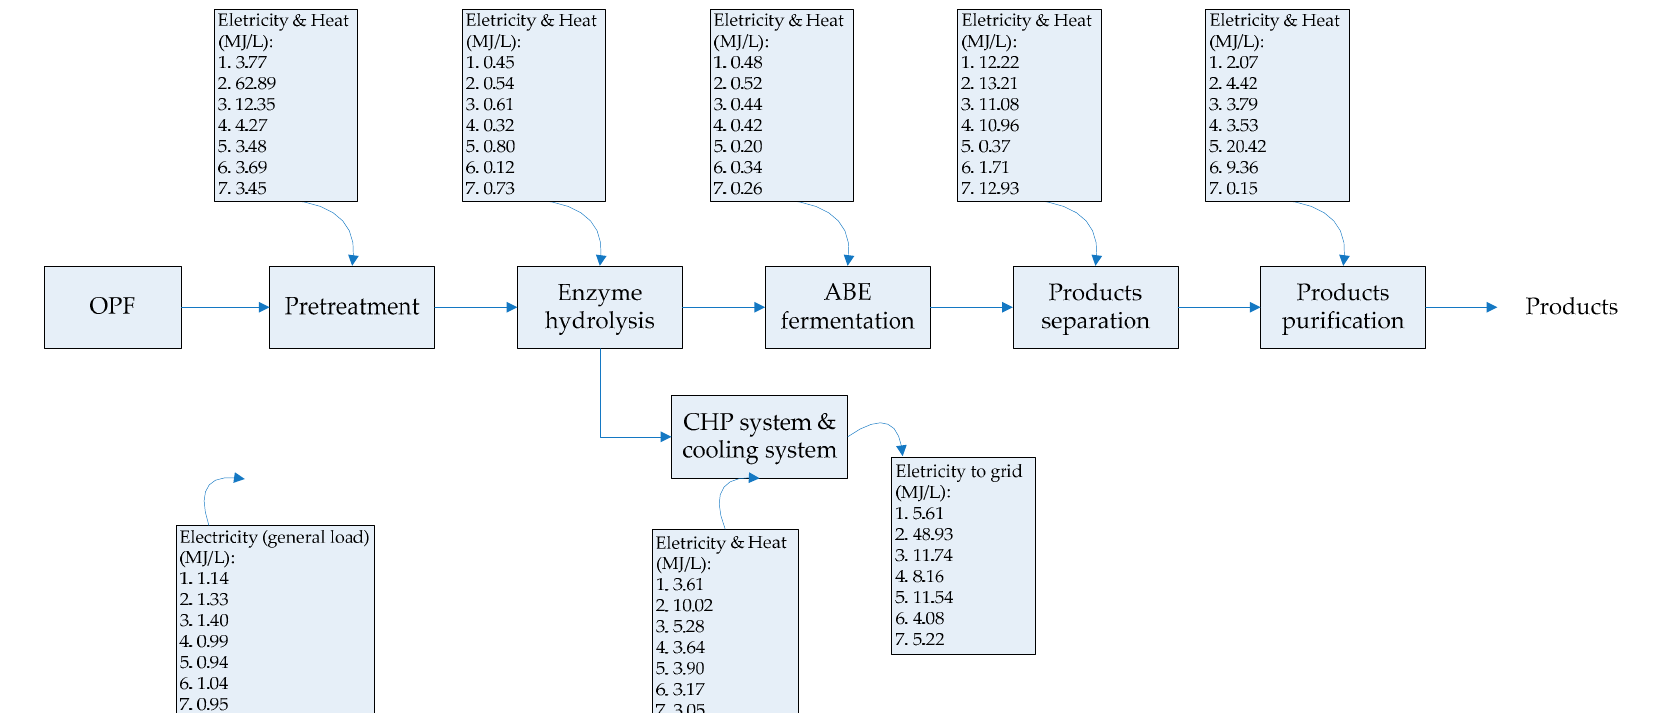
Figure 3. Energy required in each processing stage for butanol production. Numbering in boxes indicates various pretreatment or product separation steps. 1. low moisture anhydrous ammonia (LMAA) pretreatment / in-situ stripping; 2. autohydrolysis pretreatment; 3. soaking in aqueous ammonia (SAA) pretreatment; 4. NaOH pretreatment; 5. adsorption; 6. pervaporation; 7. dual extraction. The energy requirement / generated were assessed based on 1 L butanol. Products produced are butanol, acetone, and ethanol. OPF = oil palm frond; ABE = Acetone Butanol Ethanol; CHP = combined heat and power.